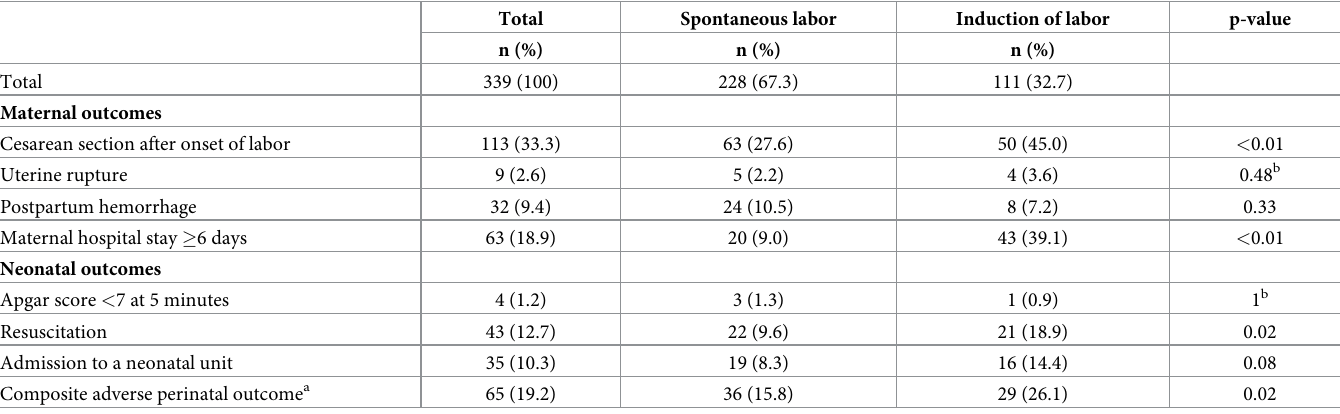
Table 3. Maternal and neonatal outcomes according to the mode of onset of